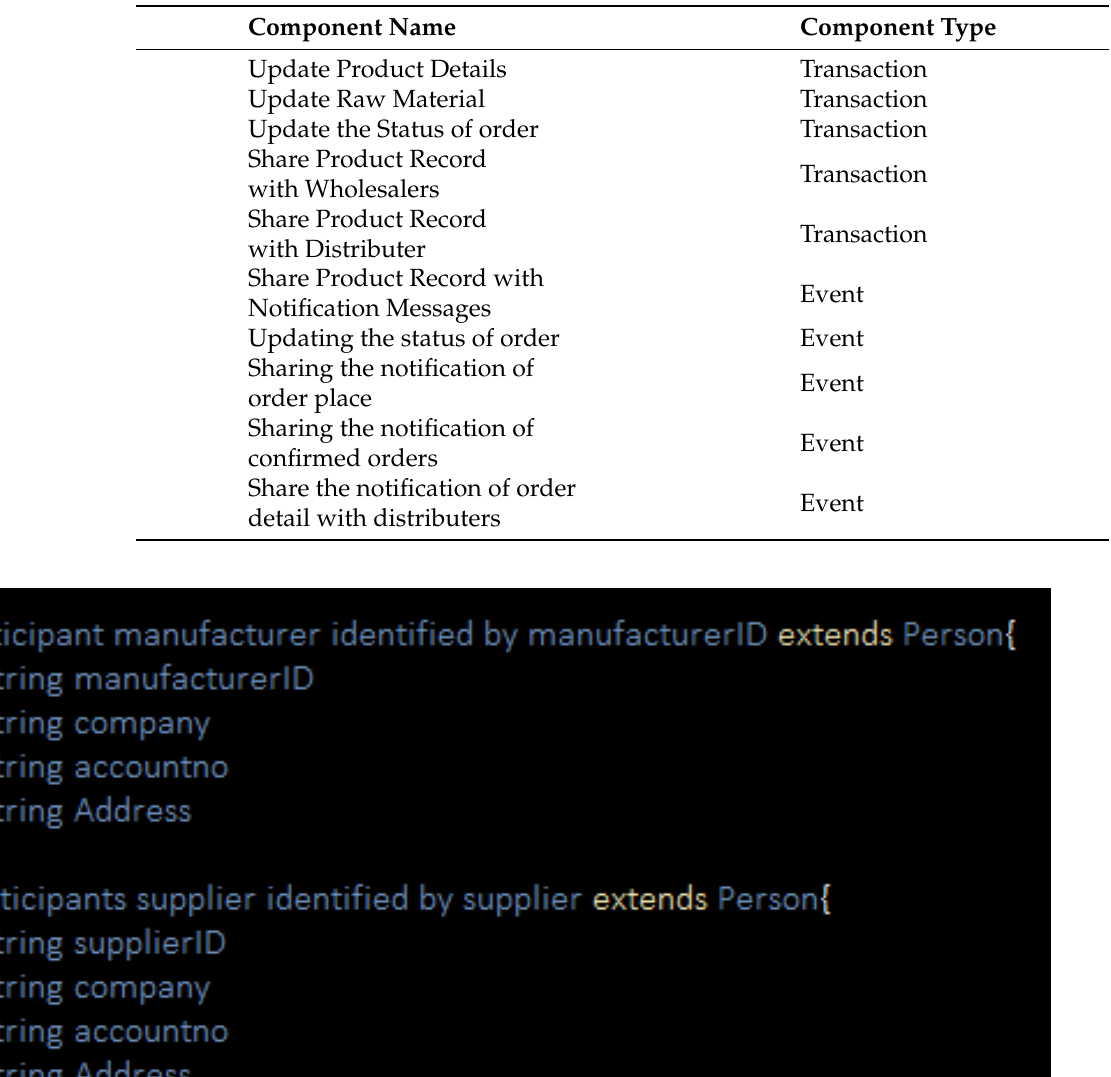
Table 3. Definitions of transactions in the proposed system.